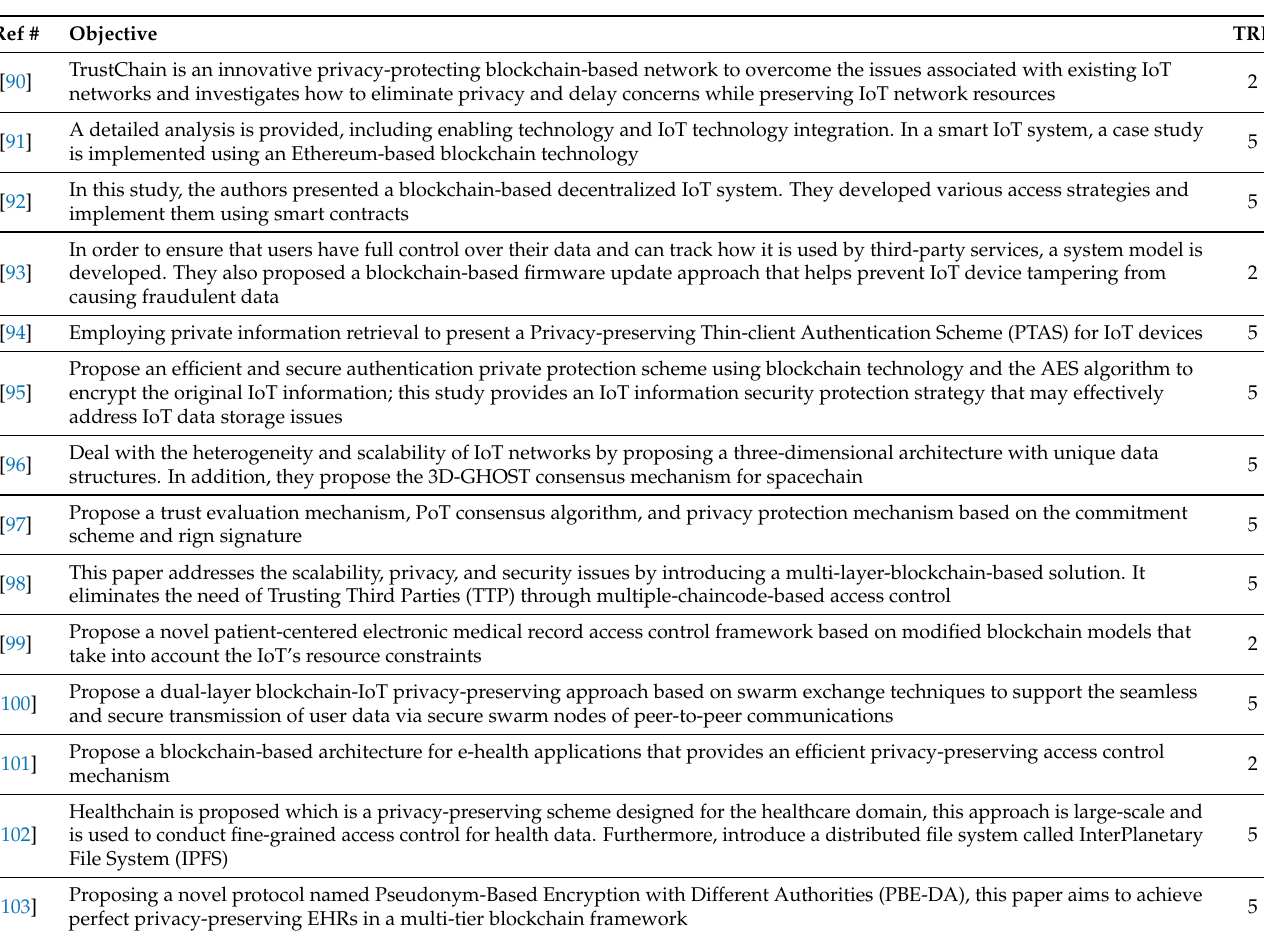
Table 2. Objective and Technology Readiness